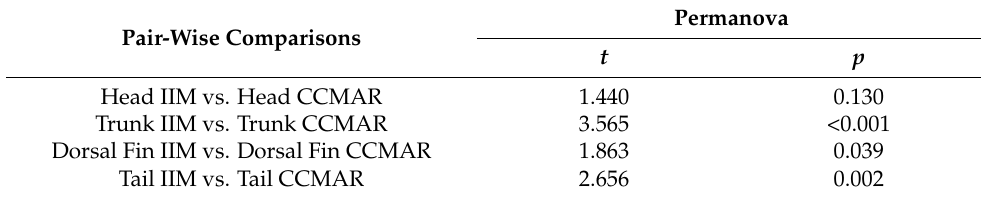
Table 2. Pairwise comparisons of two-way crossed permutational multivariate analysis of variance (PERMANOVA) between the elemental fingerprints of the bony structures of four body parts (head, trunk, dorsal fin and tail) of long-snouted seahorses ( Hippocampus guttulatus ) from Instituto de Investigaciones Marinas (IIM) (Galicia, Spain) and Centro de Ci ê ncias do Mar (CCMAR) (Algarve, Portugal) ( n = 5).